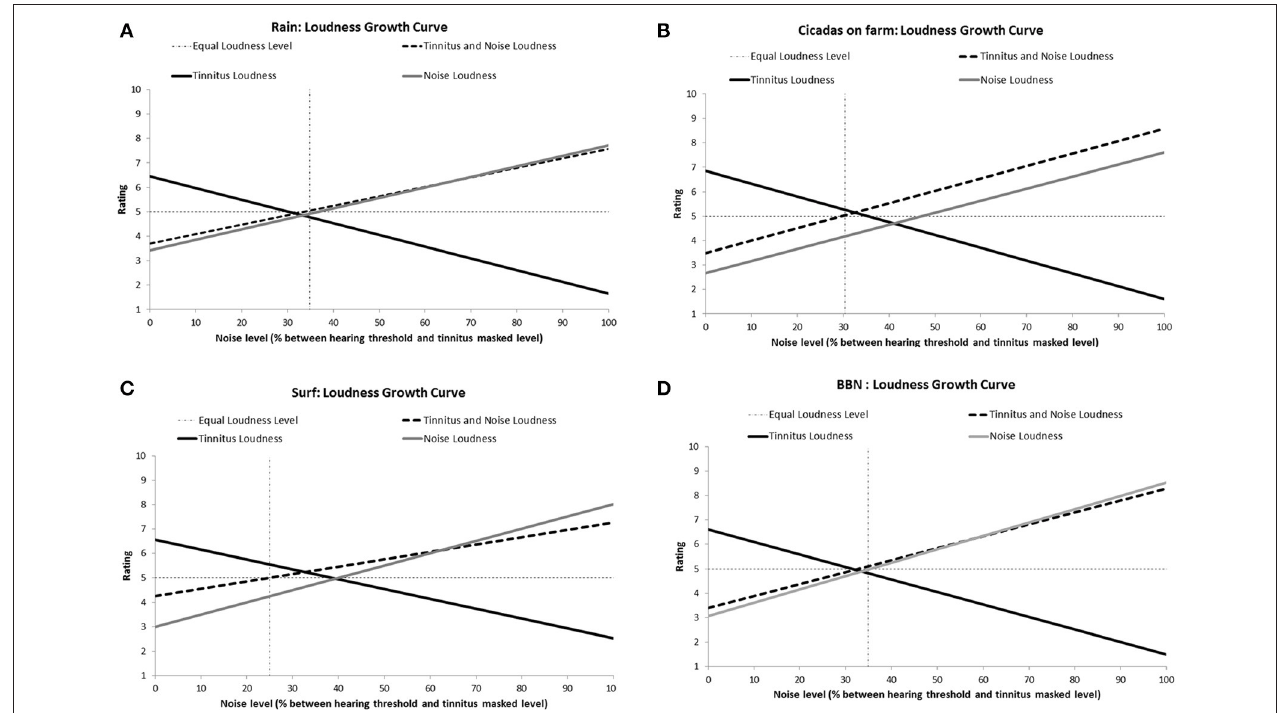
FIGURE 3 | Loudness ratings growth curves for each therapy sound [Rain (A) , Cicadas on farm (B) , Surf (C) , BBN (D) ] as a function of noise level (% between hearing threshold and minimum masking level for tinnitus). Loudness functions show decreases in tinnitus loudness (solid black line), increases in sound loudness (solid gray line), and increases in combined tinnitus and sound loudness as a function of sound level (dashed line). The Equal Loudness Level (vertical dashed line) defines the sound level at which both tinnitus and sound were of equal perceived loudness (tinnitus and sound loudness rating =